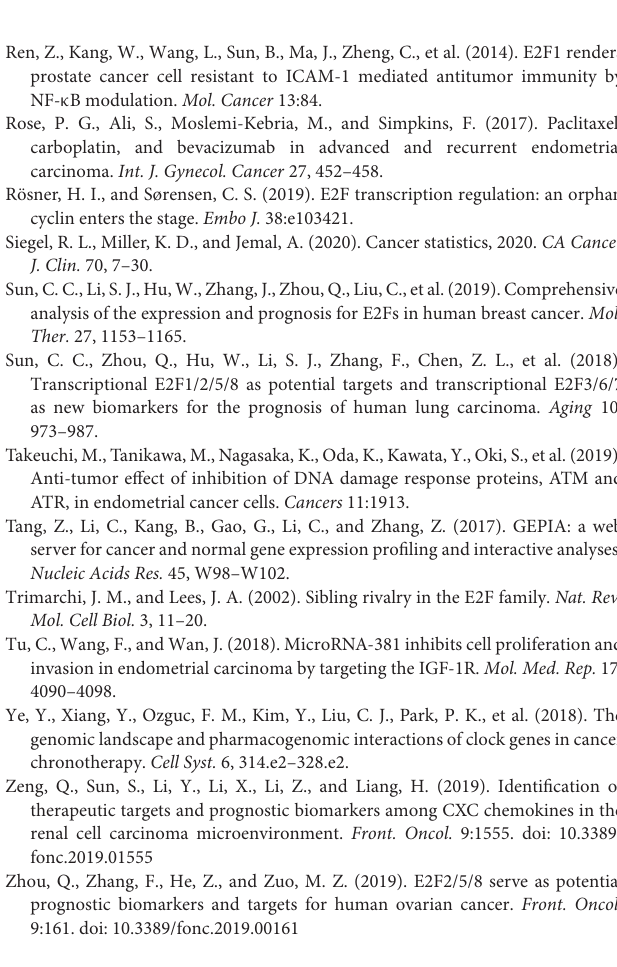
Supplementary Figure 1 | The flow chart of analyses. Supplementary Table 1 | Primer sequences for